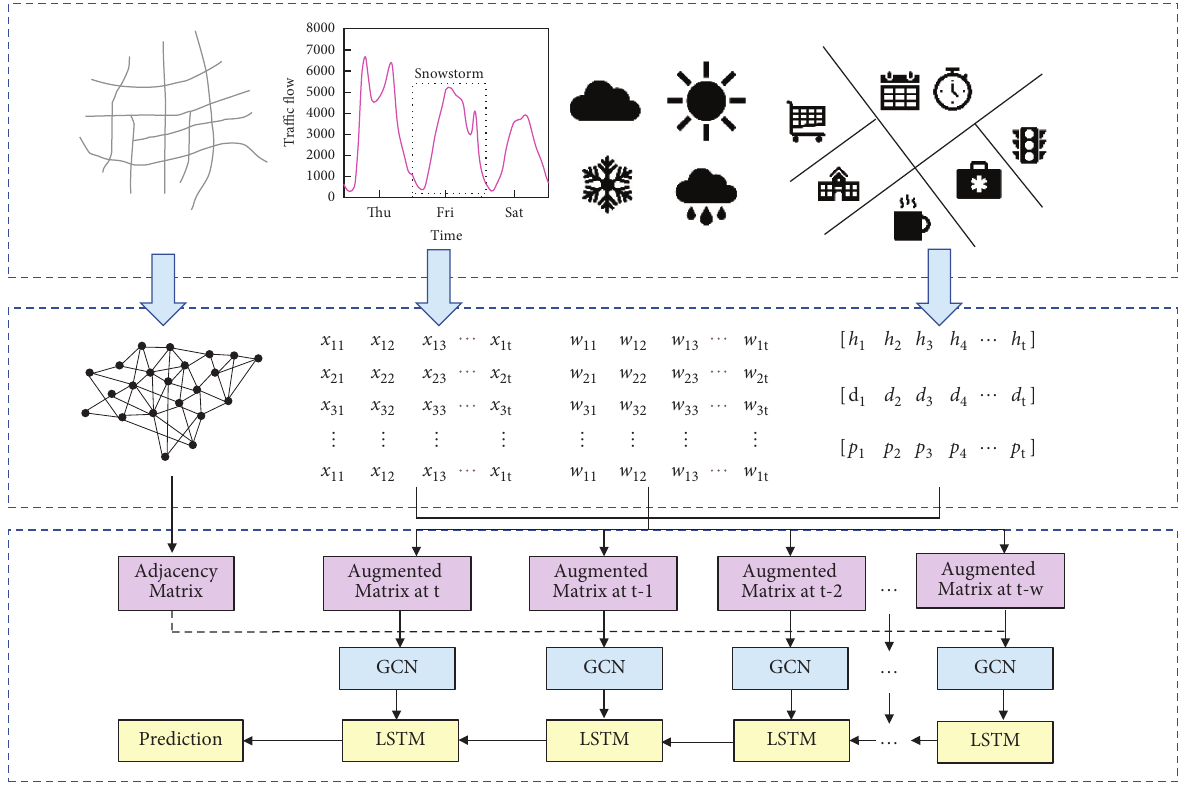
Figure 4: The architecture of the AST-GCN-LSTM